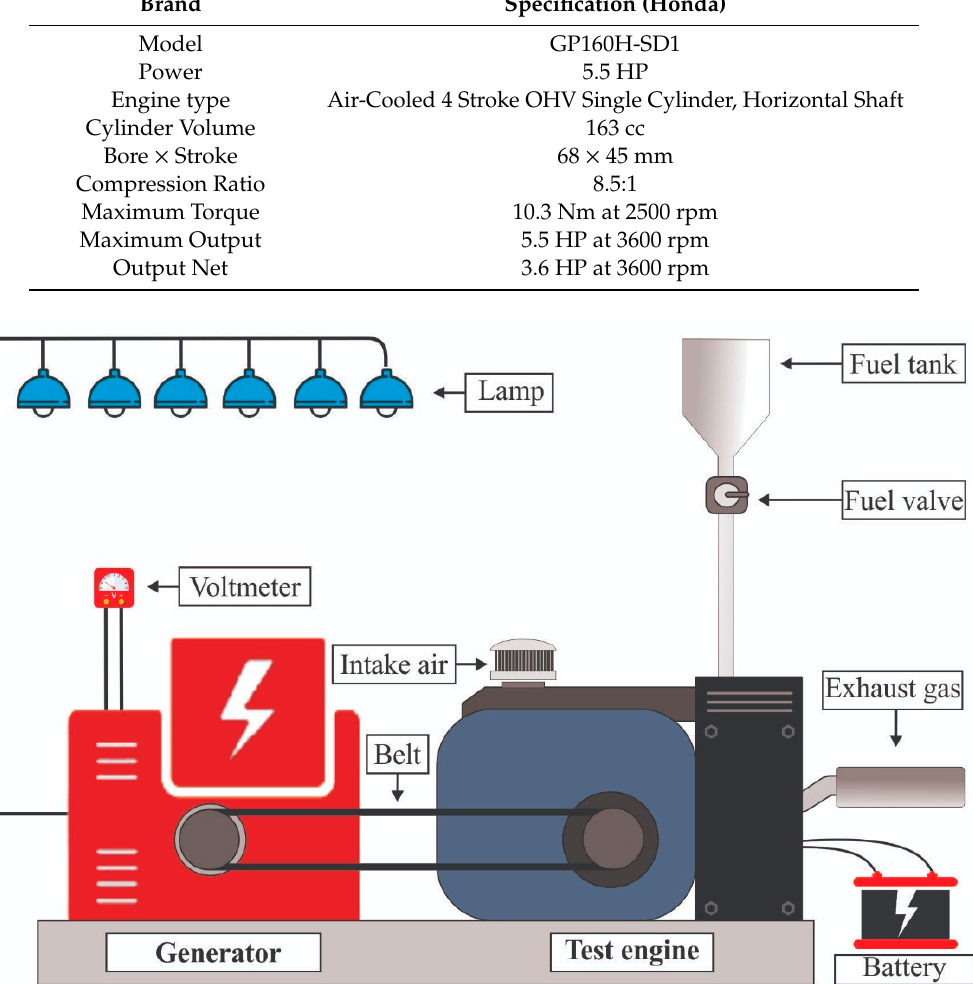
Figure 4. Schematic diagram of engine experimental setup.